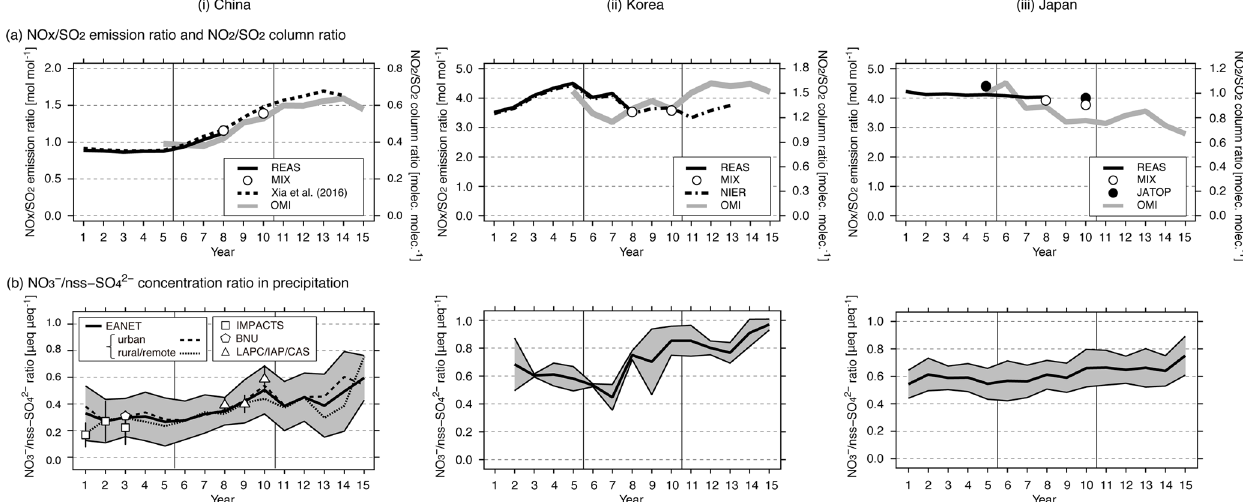
/ nss-SO 2 − concen- 3 4